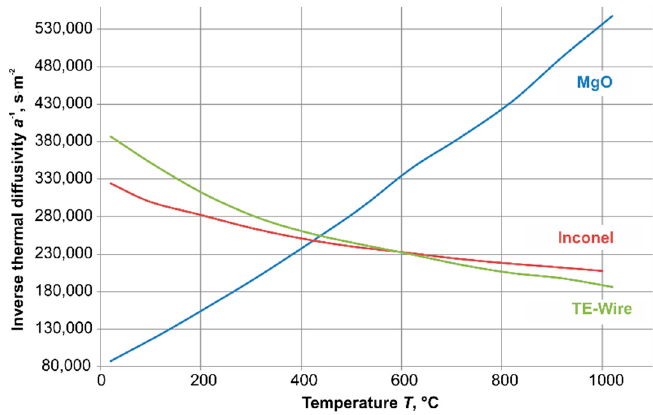
Figure 9. Thermocouple type N.